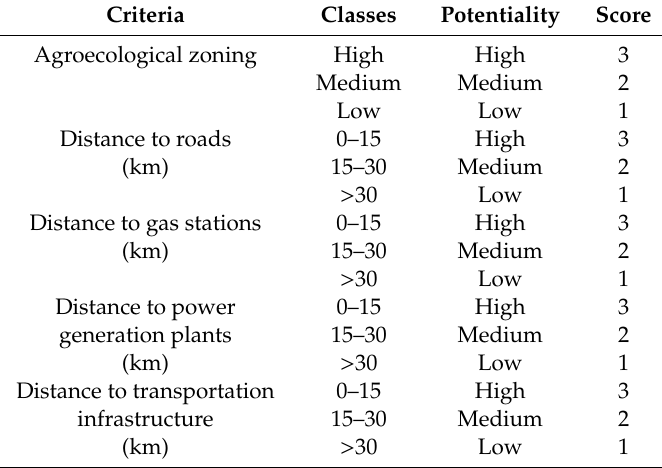
Table 5. Proximity influence on available land for JCL cultivation.